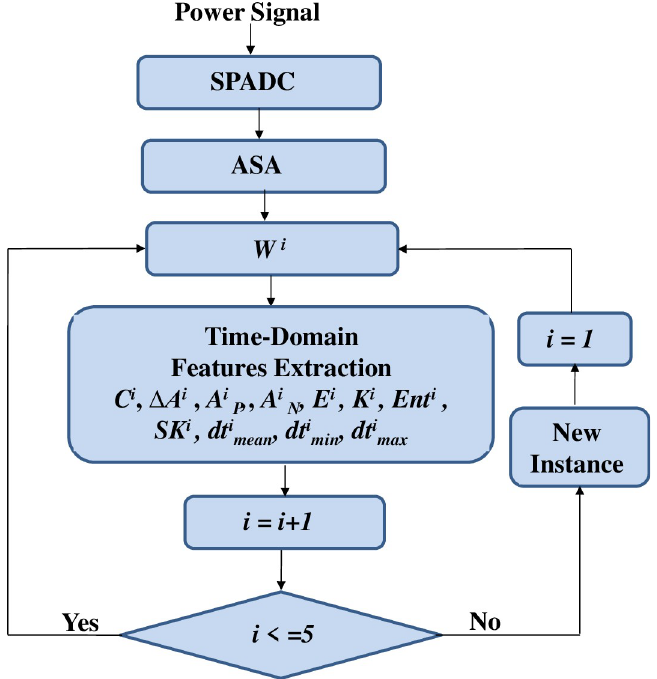
Fig 3. The features extraction